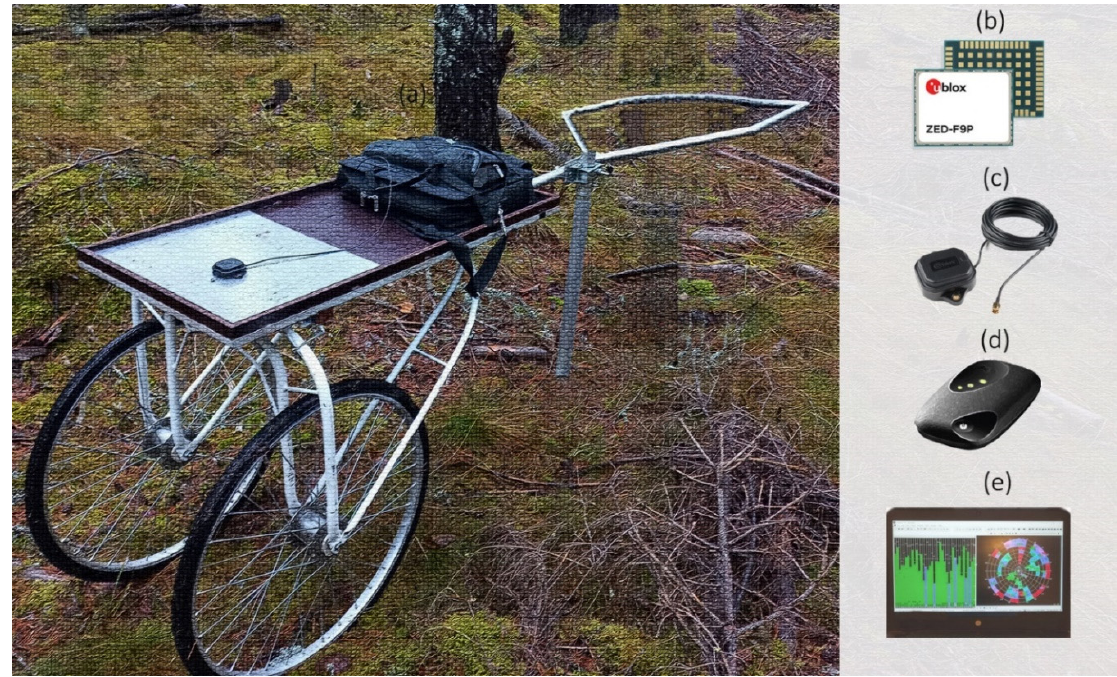
Figure 2. Compartments for field experiment: ( a ) research sulky, ( b ) u-blox ZED-F9P, ( c ) Multi band GNSS antenna ANN-MB-00 (SMA), ( d ) modem, and ( e ) computer system.